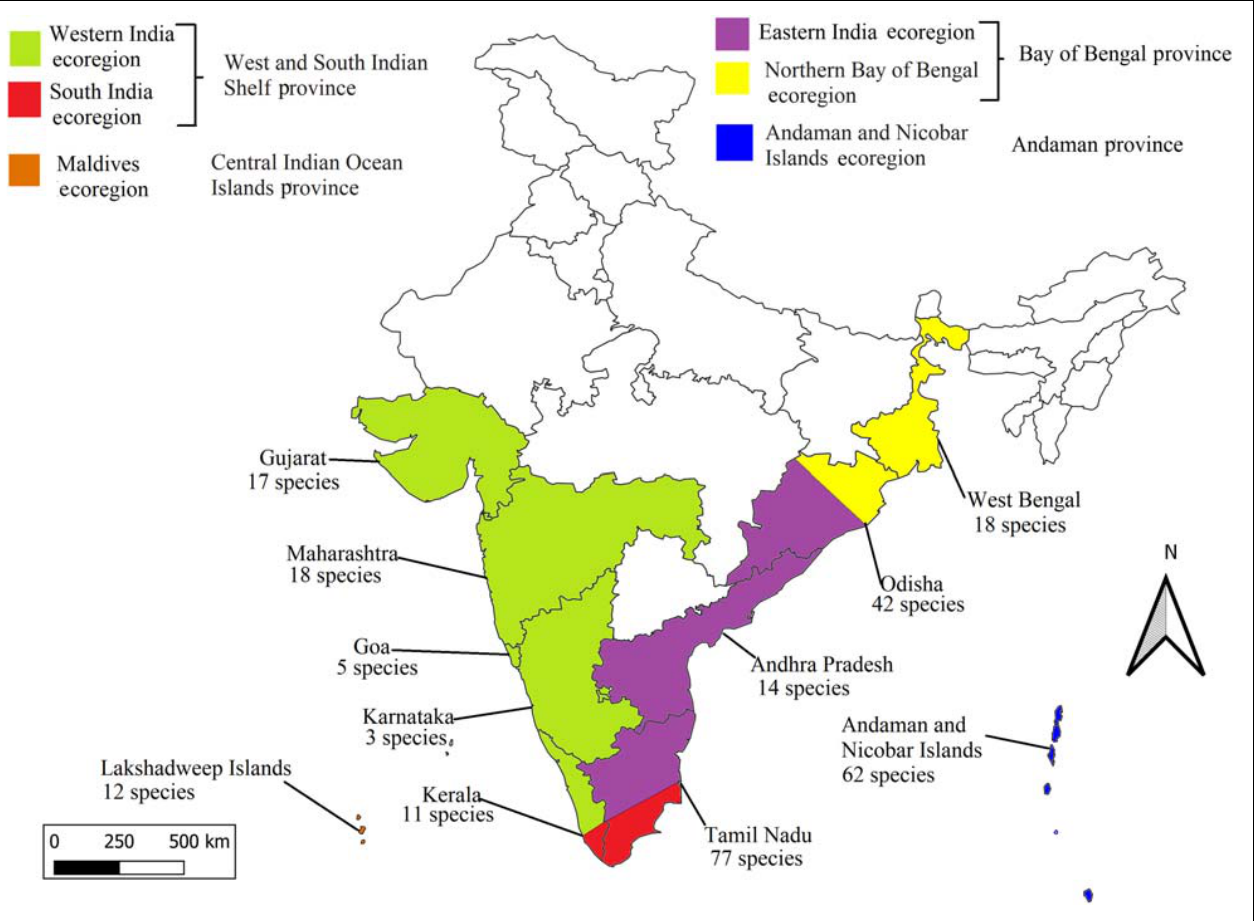
FIGURE 1 | Map of India (Sri-Lanka was not included) showing the states as well as ecoregions and provinces as defined by Spalding et al. (2007).